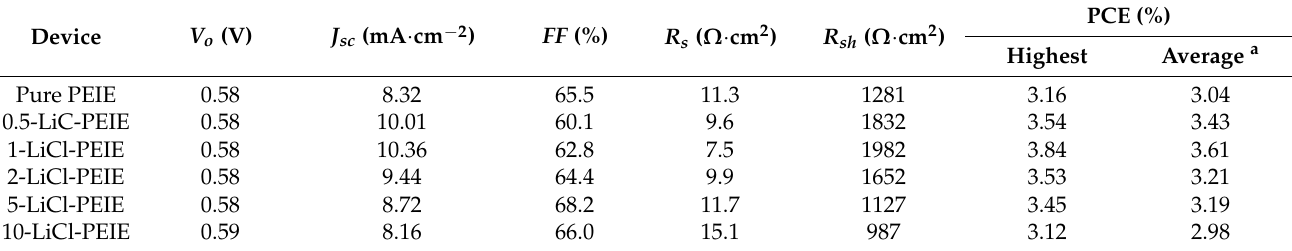
Figure 1. I – V curves of OSCs based on different ETLs, ( a ) P3HT:PCBM-based devices and ( b ) PTB7:PC 71 BM-based devices. Table 1. Performance parameters of P3HT:PCBM-based OSCs with different ETLs. The presented value is the best one observed in this study.